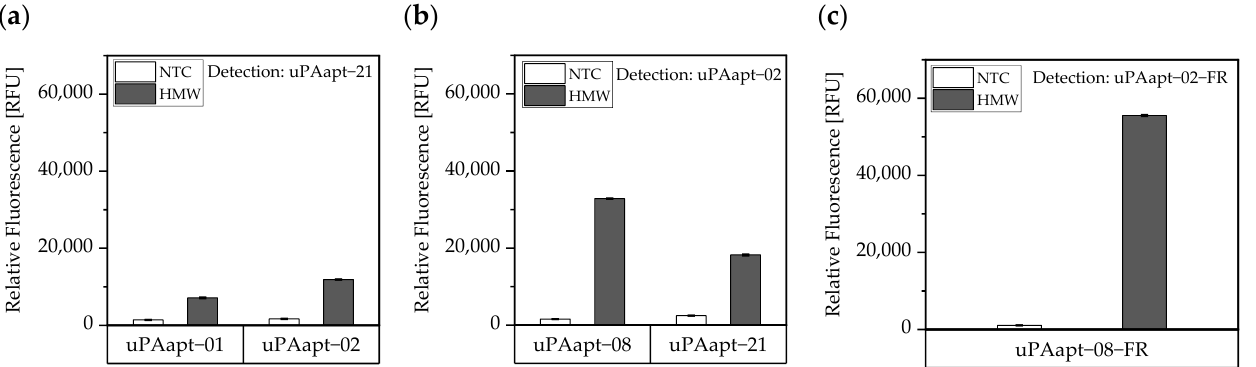
Figure 5. Aptamer-based sandwich assay for detection of HMW-uPA by different combinations of aptamers. HMW-uPA could be detected when ( a ) uPAapt − 01 or uPAapt − 02 are used as capture aptamers and uPAapt − 21 as the reporter aptamer or when ( b ) uPAapt − 08 or uPAapt − 21 are used as capture aptamers and uPAapt − 02 as the reporter aptamer or when ( c ) uPAapt − 08 − FR is used as a capture aptamer and uPAapt − 02 − FR as the reporter aptamer. The relative fluorescence unit [RFU] for each sample is given as the mean value of technical replicates and was measured using the EnVision ® 2105 multimode plate reader. Error bars represent the range of measured values. NTC = No Target Control, HMW = HMW-uPA. Number of records n =